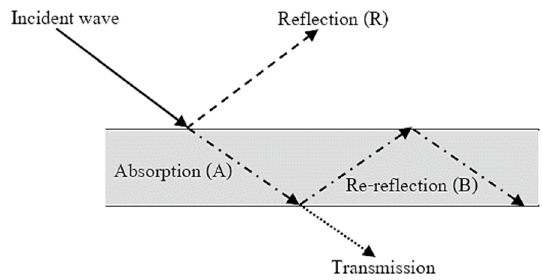
Figure 1. The mechanism of electromagnetic interference shielding effectiveness (EMI SE).